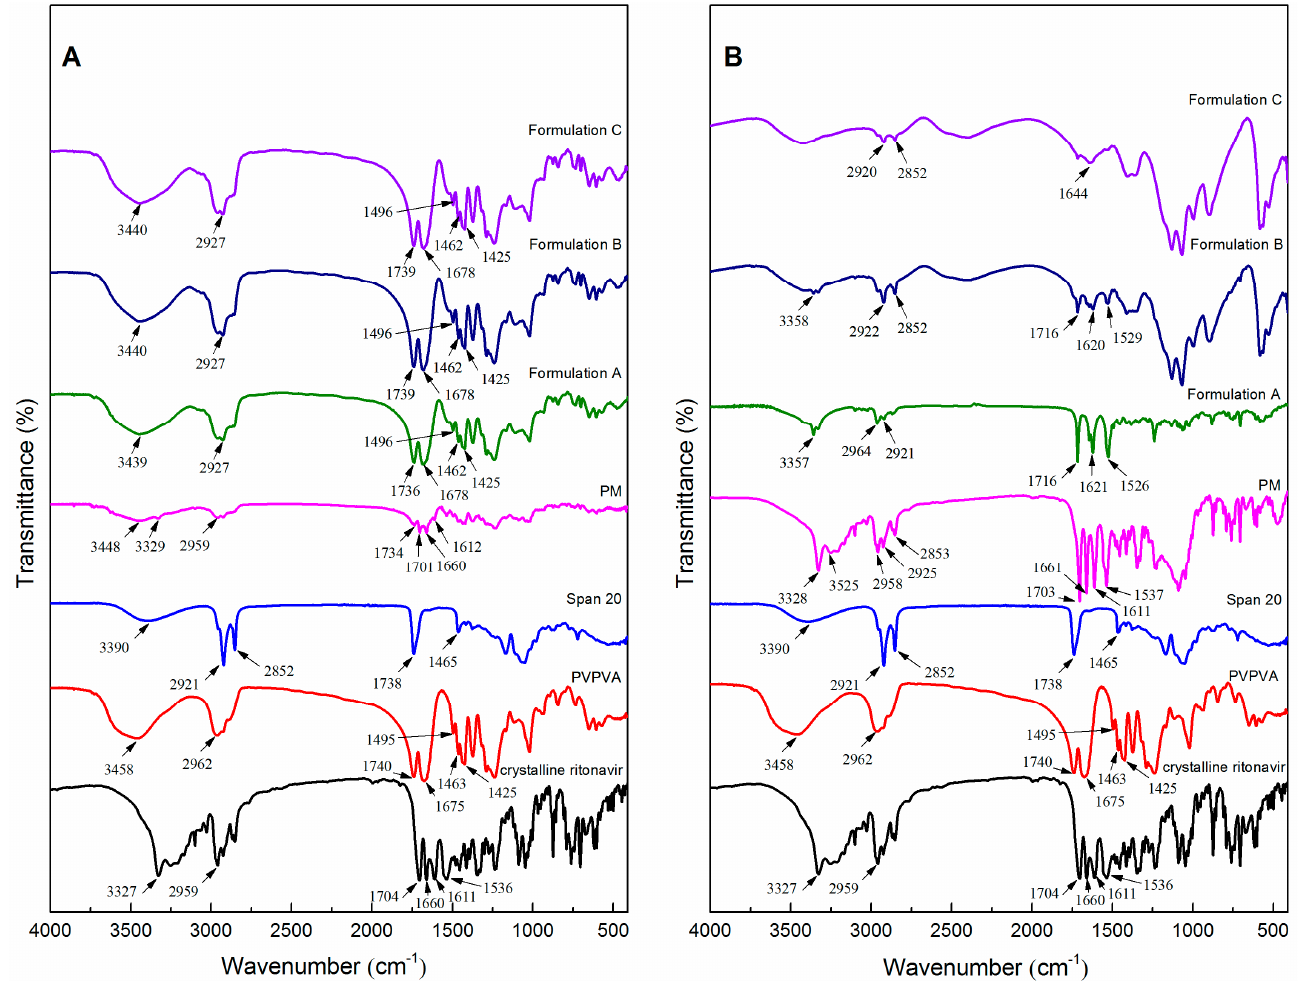
Figure 7. The infrared spectrum of milled extrudates ( A ) and precipitates ( B ). (PM: physical mixture of ritonavir/PVPVA/Span 20).